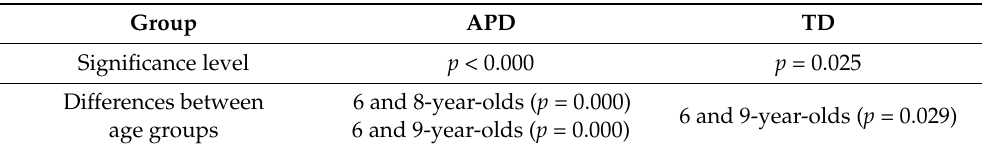
Table 6. Analysis of differences between age groups for the PDT results, in APD and TD groups, with the application of the post hoc tests (multiple comparisons tests of mean ranks for all samples). Group APD TD